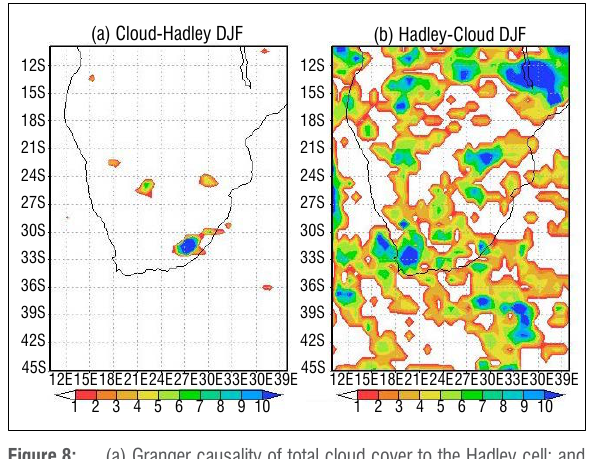
Figure 8: (a) Granger causality of total cloud cover to the Hadley cell; and (b) Hadley cell to total cloud cover in December–February (DJF). (b) Hadley-Cloud JJA(a) Cloud-Hadley JJA